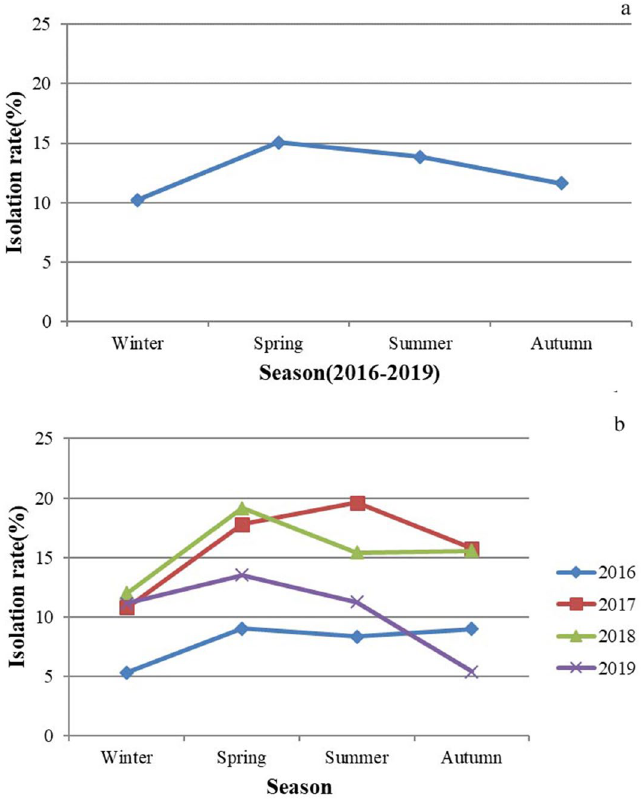
Figure 2. LPAIVs seasonal isolation rates. (a) The average isolation rates in the winter, spring, summer and autumn for four years from 2016 to 2019; (b)The seasonal isolation rates in each year from 2016 to 2019.